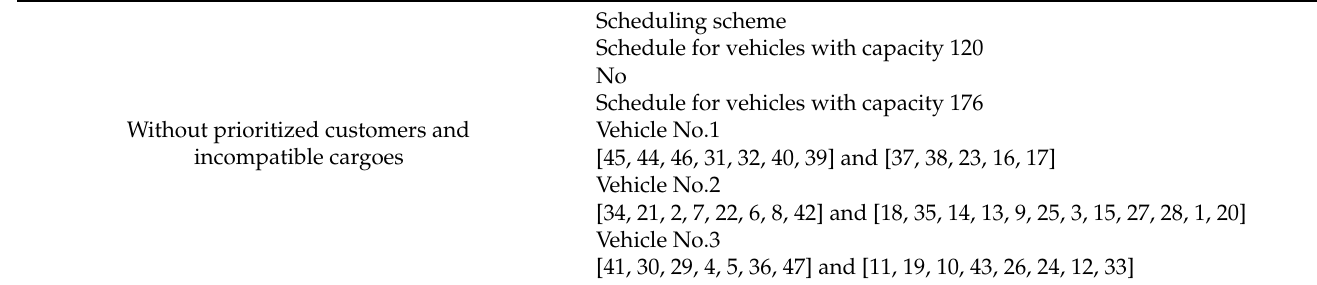
Table 4. Vehicle routes without prioritized customers and incompatible